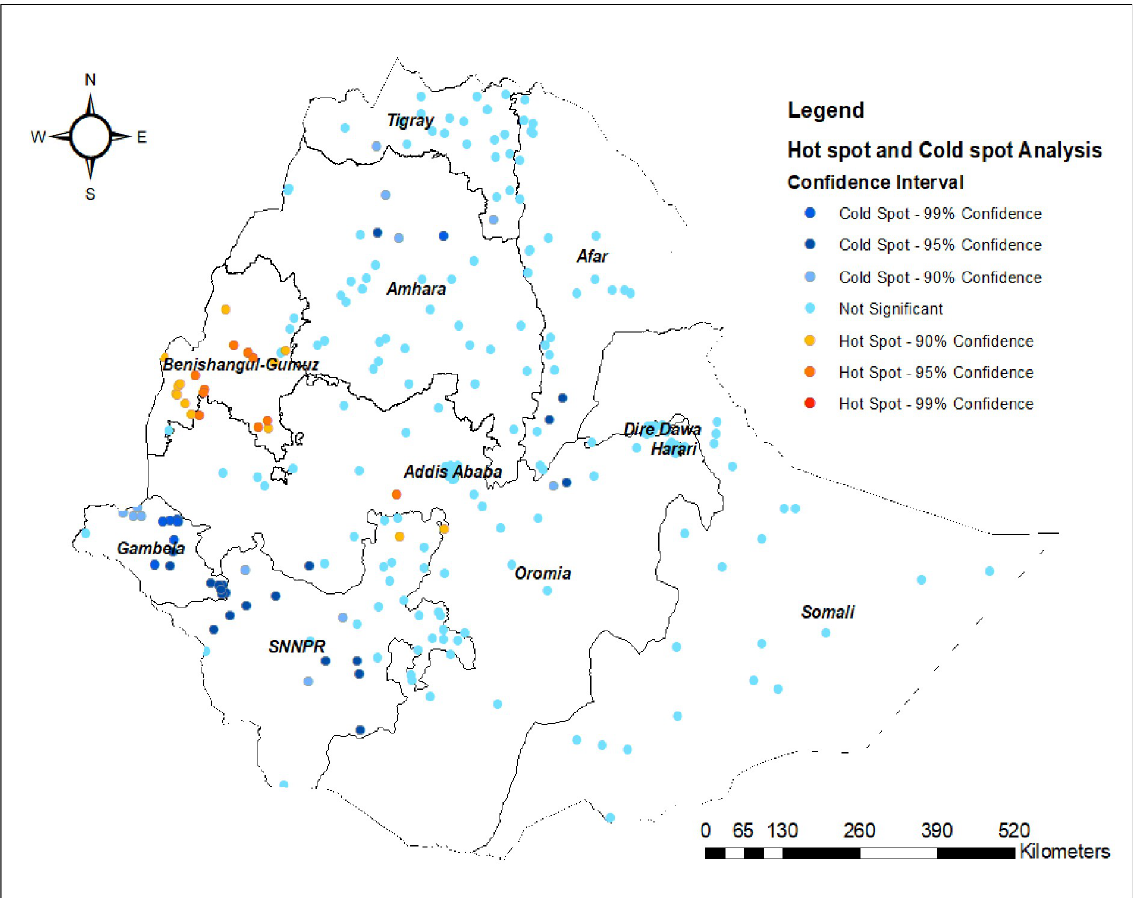
Fig 4. Hot spot and cold spot analysis of non-uptake of MCV2 in Ethiopia, Map produced using Arc GIS version 10.7.